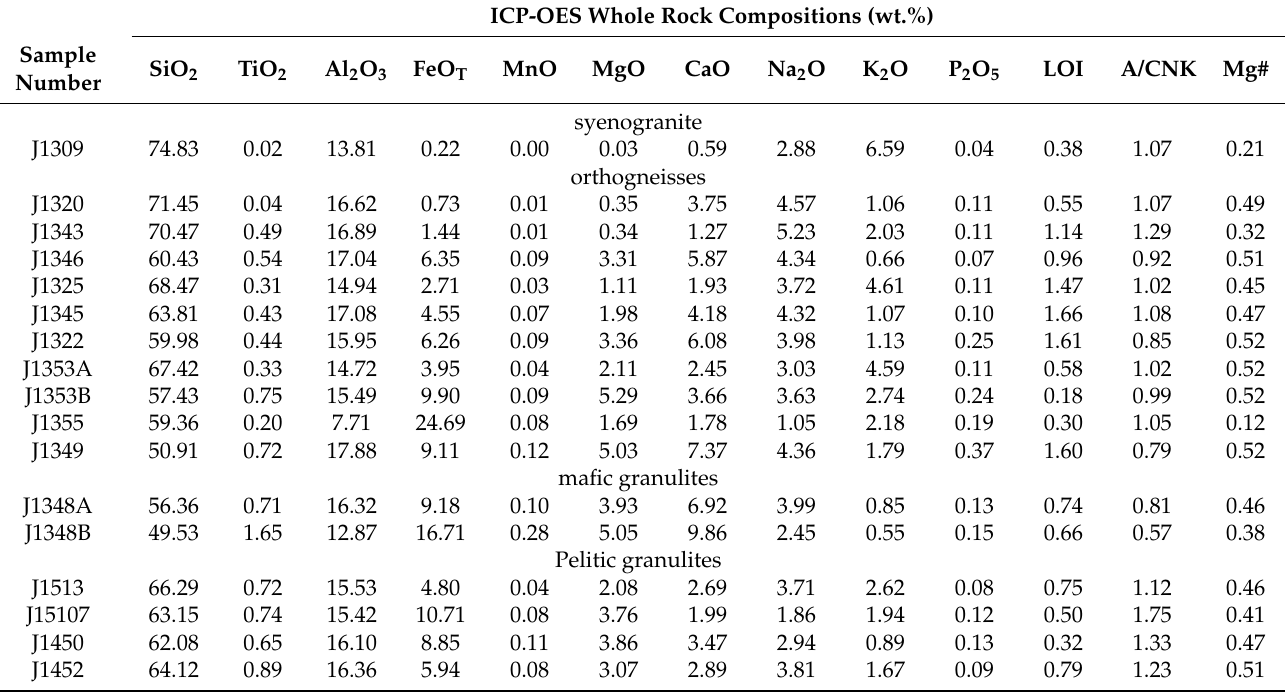
Table 1. Whole-rock geochemical compositions of representative samples from Eastern Hebei. ICP-OES Whole Rock Compositions